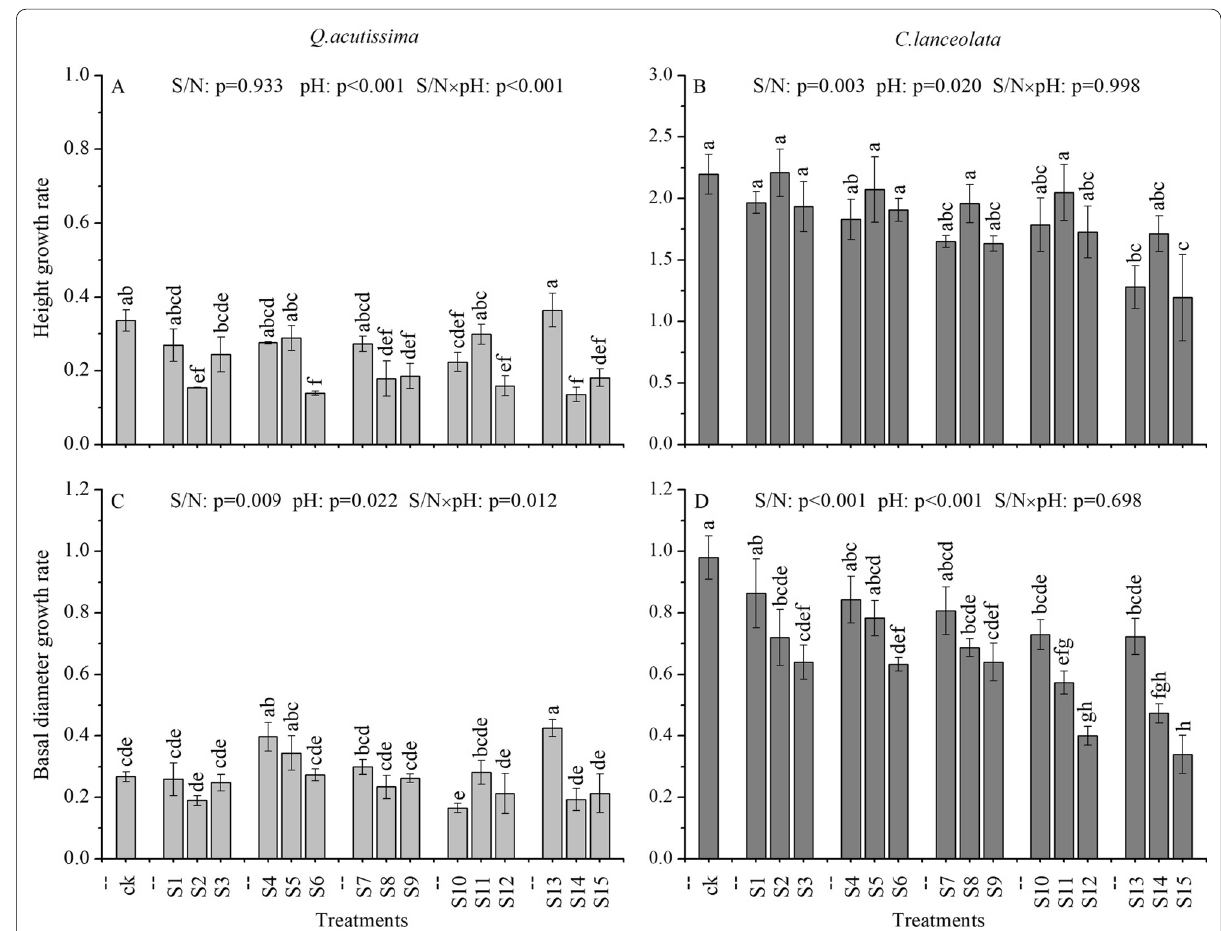
Fig. 1 Variations in growth rates between treatments. Mean labeled with same letters indicate no significant difference at p ˂ 0.05. The main impacts and interactivity of the AR S/N ratio and pH were assessed by two‑way